Question: Generate an informative caption for the figure above.
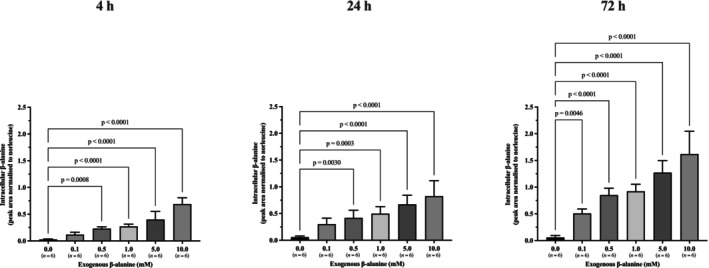
Answer: Intracellular β‐alanine in differentiated H9c2 cells after 4, 24, and 72 h of exogenous β‐alanine incubation. Data are calculated as analyte peak area normalized to the internal standard (Norleucine) peak area and presented as mean ± 1 SD. Replicate numbers included in analysis are presented underneath each respective concentration.